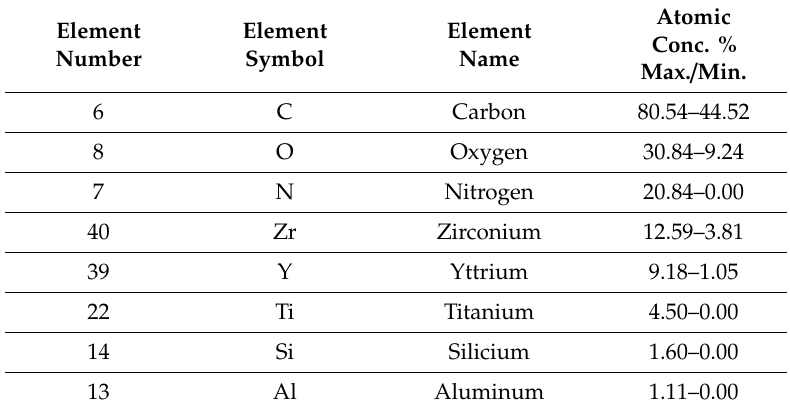
Table 3. Chemical analysis of particulate residues on zirconia / Ti-Base samples before ultrasonic cleaning by element and maximum / minimum atomic concentration.